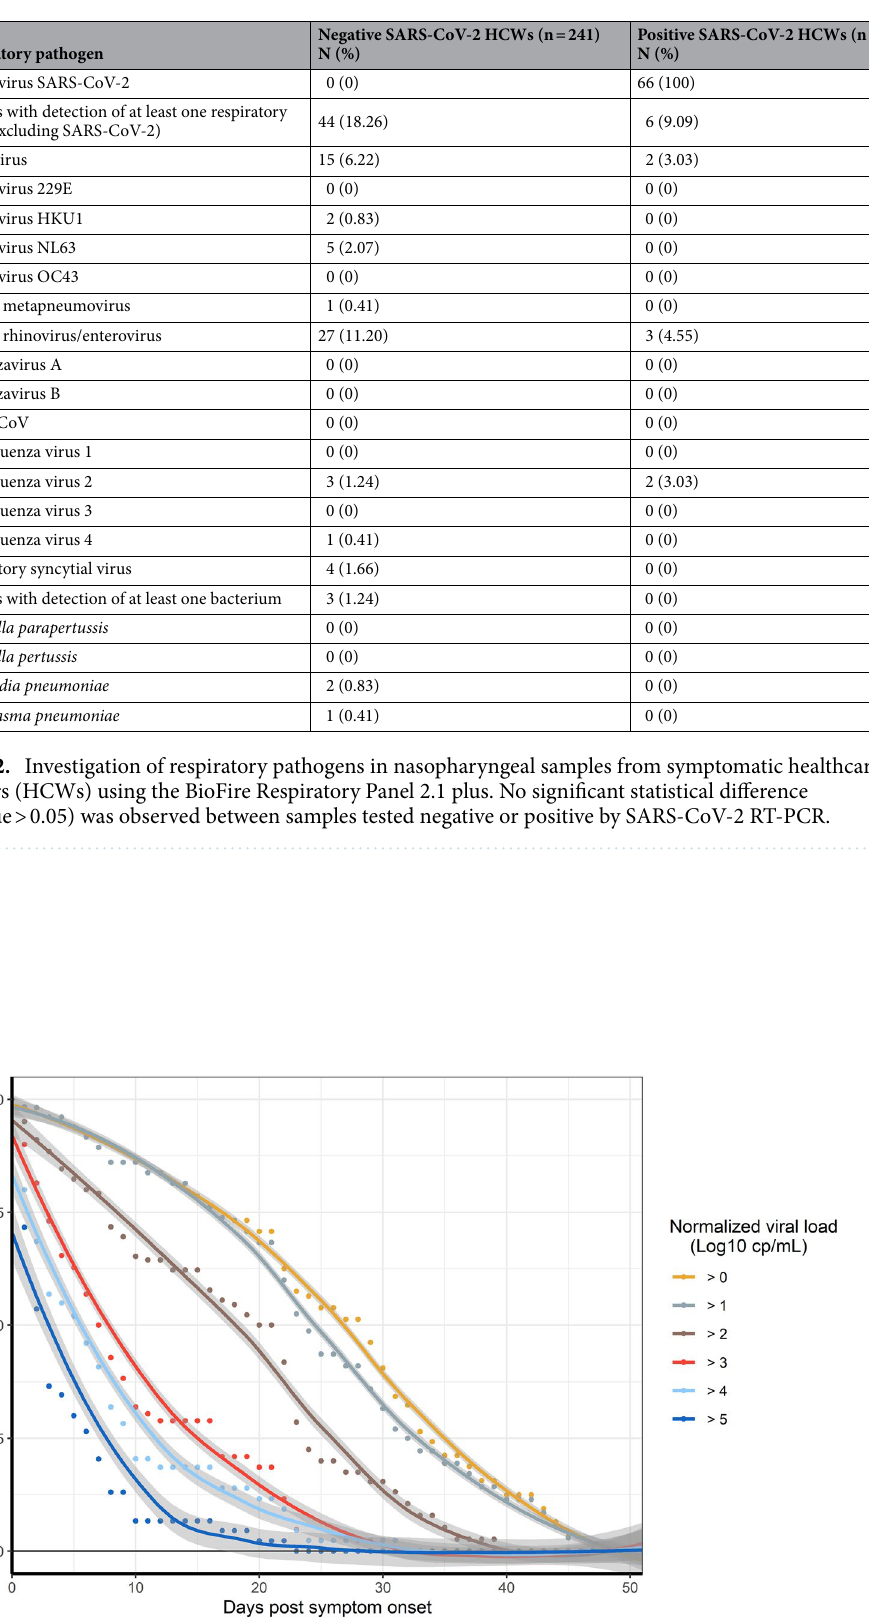
Figure 2. Longitudinal proportion of positive SARS-CoV-2 healthcare workers according to the normalized viral load. Fit Loess curve represents local polynomial regression performed with Loess method. The 95% confidence interval (CI) is indicated (grey